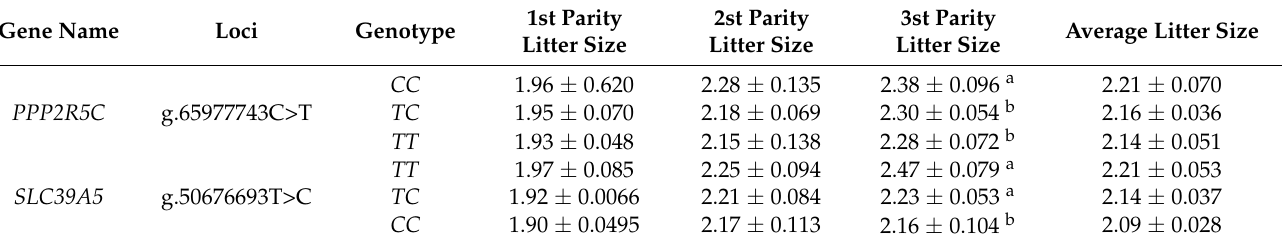
Table 6. Analysis of associations between polymorphisms and litter size in Yunshang black